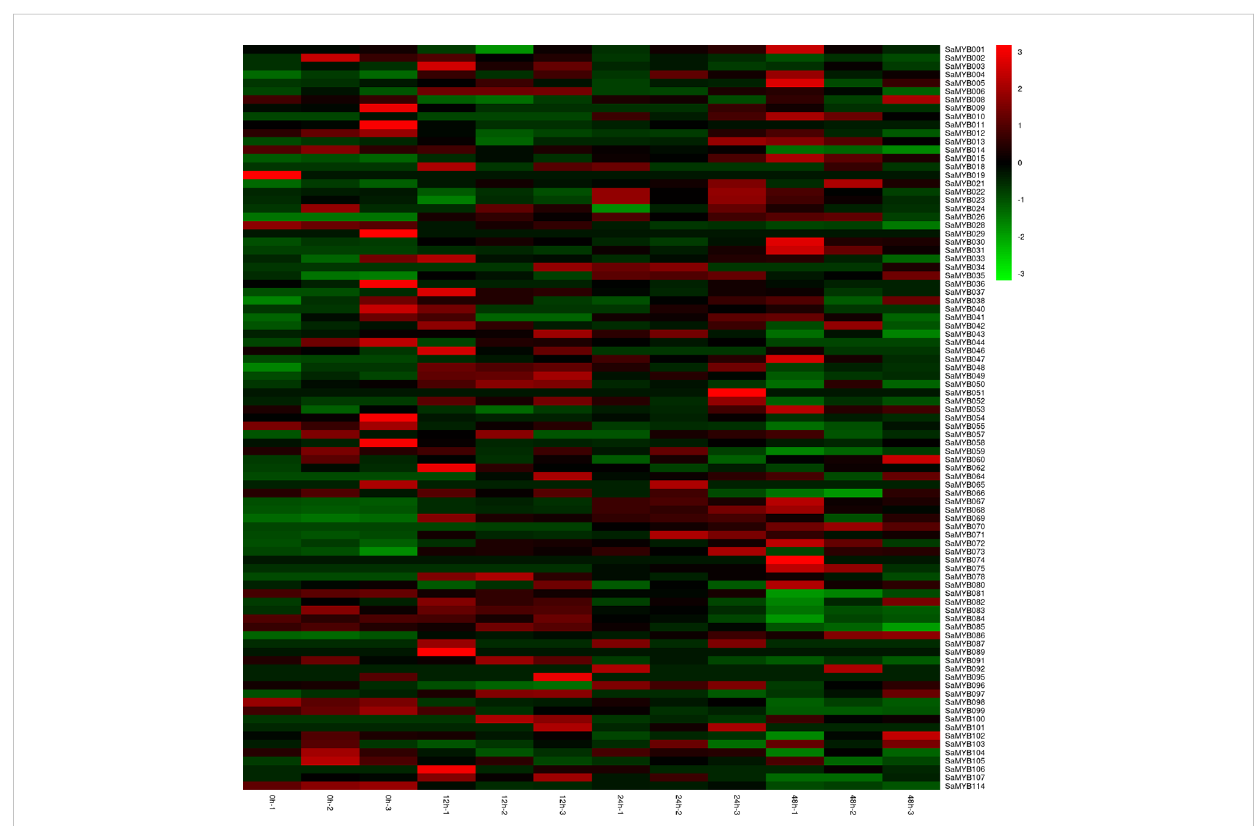
FIGURE 5 R2R3-MYB gene expression levels determined by RNA-seq at the four time points of cold (4°C) treatment. Expression pro fi les were normalized to log 10 (FPKM). The color scale represents relative expression level from low (green) to high (red)